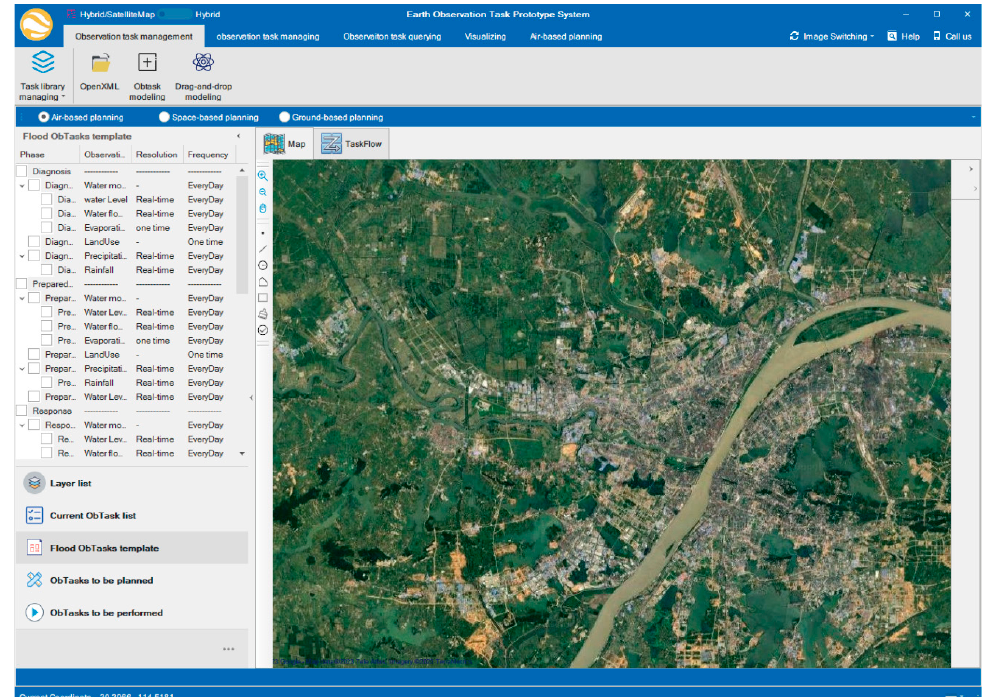
Figure 7. Main interface of the prototype system.